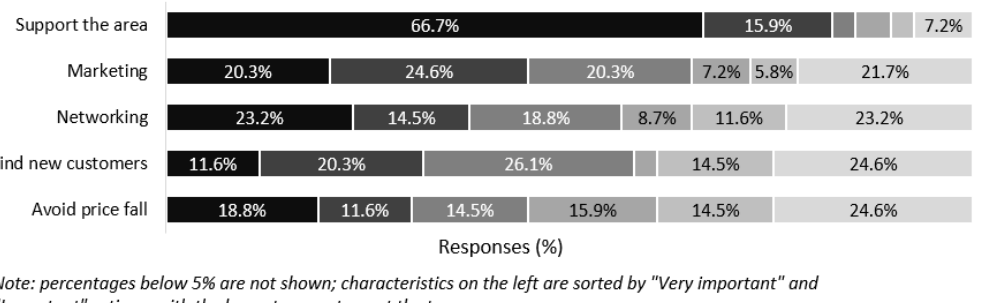
Figure 3. Sources from which responding organizations came to know about the PEFC fair supply chain (total is >100% because multiple responses were allowed).